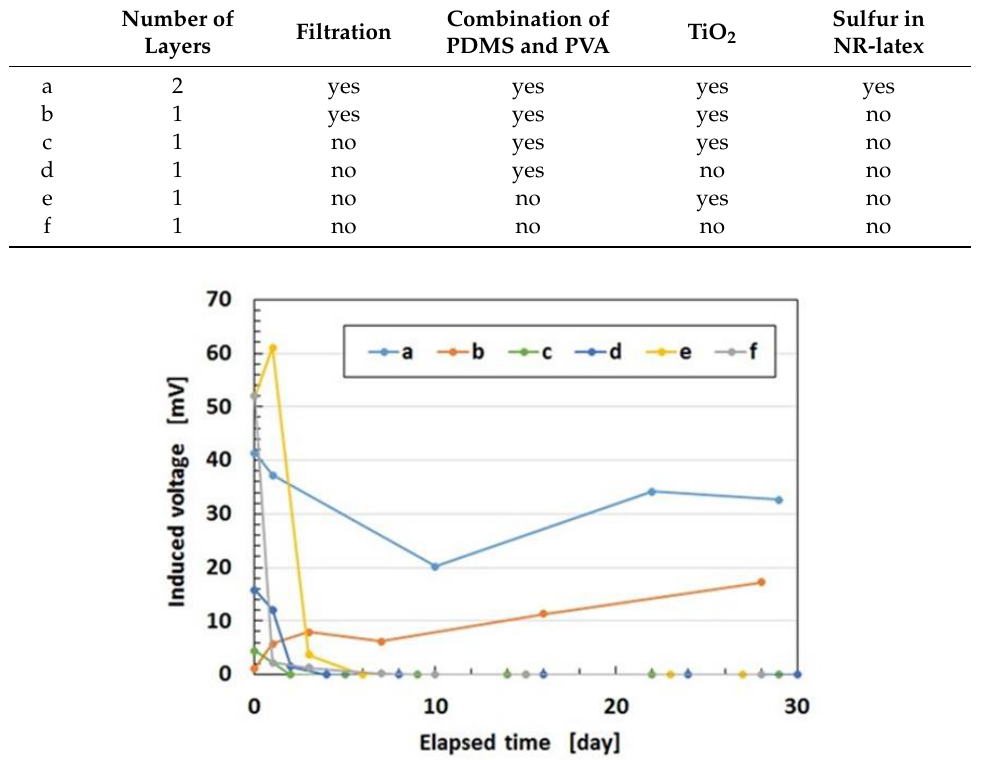
Figure 11. Change of the induced voltage with elapsed time.